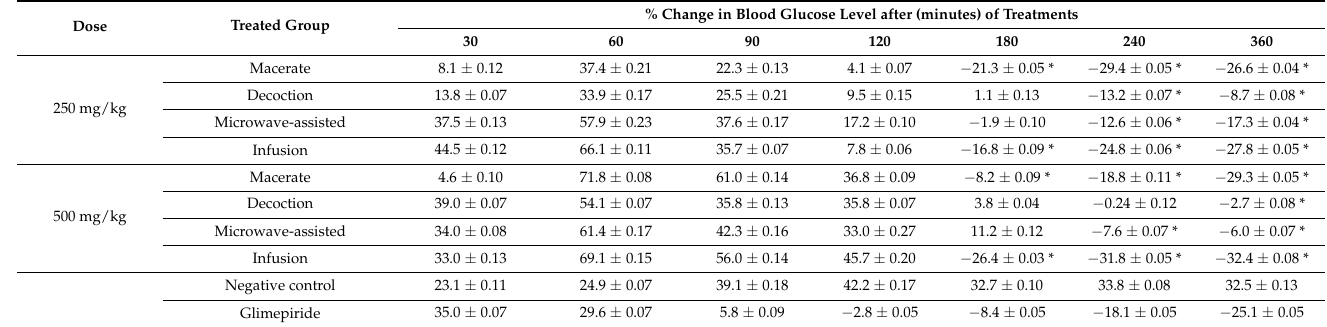
Figure 6. The change in blood glucose level in diabetic mice induced by a single dose of 500 mg/kg Terfezia claveryi extracts. Each bar represents the mean ± SEM for ( n = 6) mice per treated group. Table 3. Percentage change of blood glucose after a single dose administration of Terfezia claveryi crude extracts.